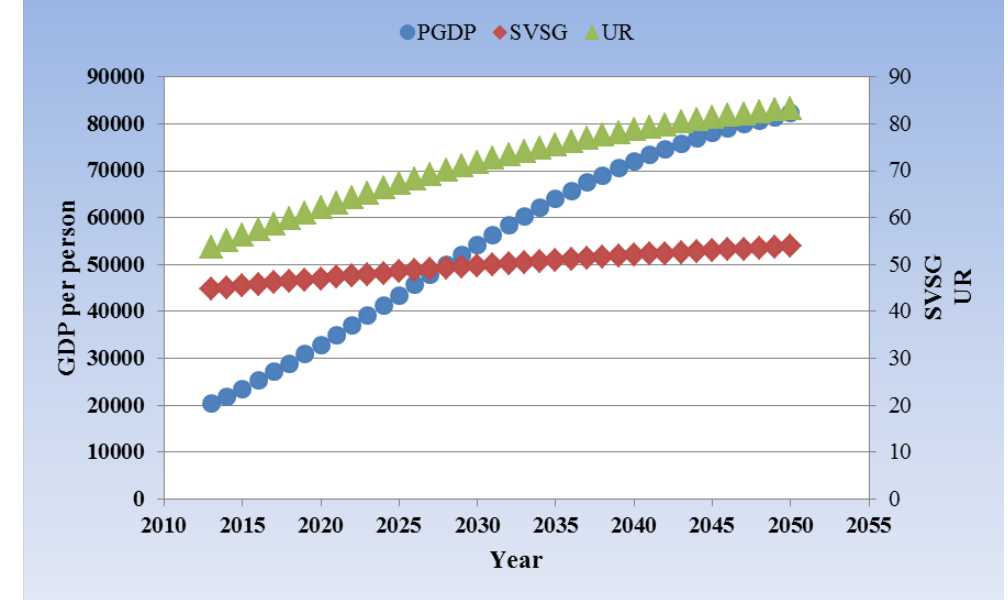
Figure 12. Forecasting values of GDP per capita, SVSG and urbanization rate of Hubei Province from 2013 to